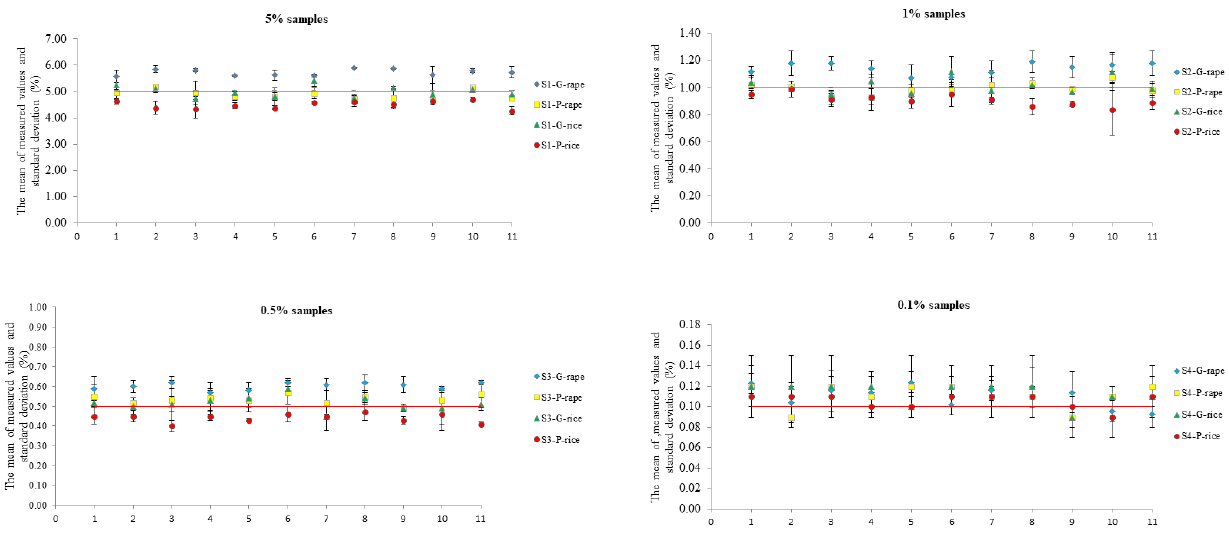
Figure 2. Distribution of measurement average together with a standard deviation by ddPCR targeting 11 different elements for each test sample. 1–11 correspond to the dPCR assays of Bar , assays targeting 11 different elements for each test sample. 1 – 11 correspond to the dPCR assays of P- CaMV 35S, P- FMV 35S, T-NOS, HPT , NPTII , P-NOS, T-35S, Pmi , T-e9 and Bar , P- CaMV 35S, P- FMV 35S, T-NOS, HPT , NPTII , P-NOS, T-35S, Pmi , T-e9 and T-g7.